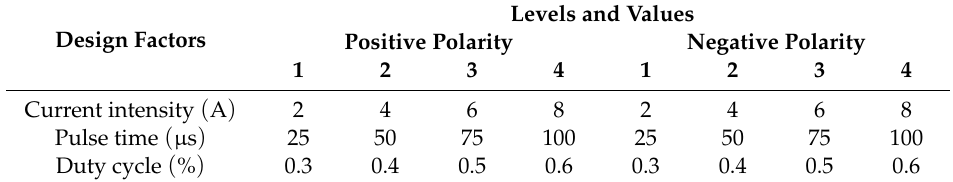
Table 2. Mean values of arithmetical mean roughness (Ra), material removal rate (MRR), and electrode wear (EW), obtained with positive and negative polarity. These values were taken from Reference [2] Torres Salcedo, A.; Puertas Arbizu I.; Luis P é rez, C. J. Analytical Modeling of Energy Density